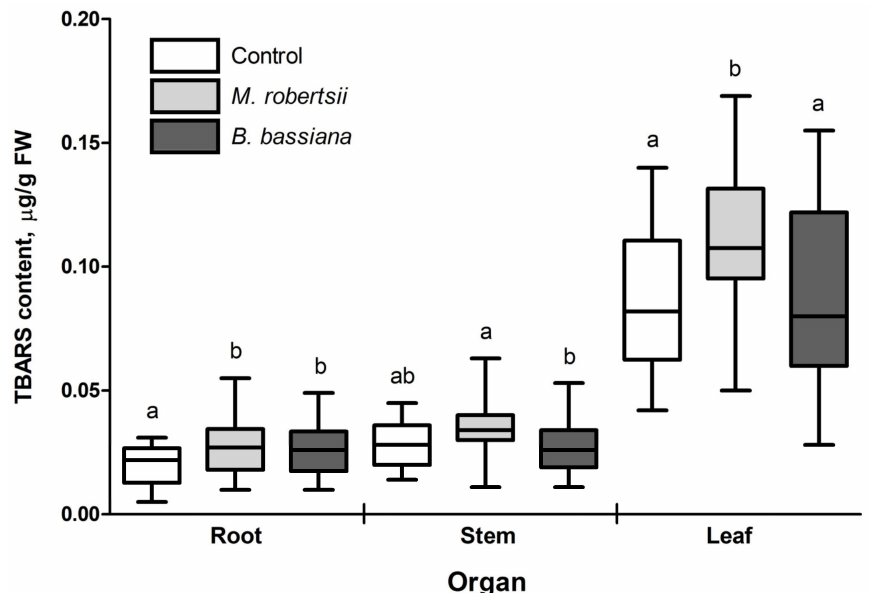
Figure 3. Effect of treatment with EIPF on the TBARS content in plant organs. Twenty-five plants were used for each treatment. The results are presented as the median, 25–75% quartile deviation and min and max values. Different letters show significant differences between treatments for each group (Dunn’s test, p < 0.05).